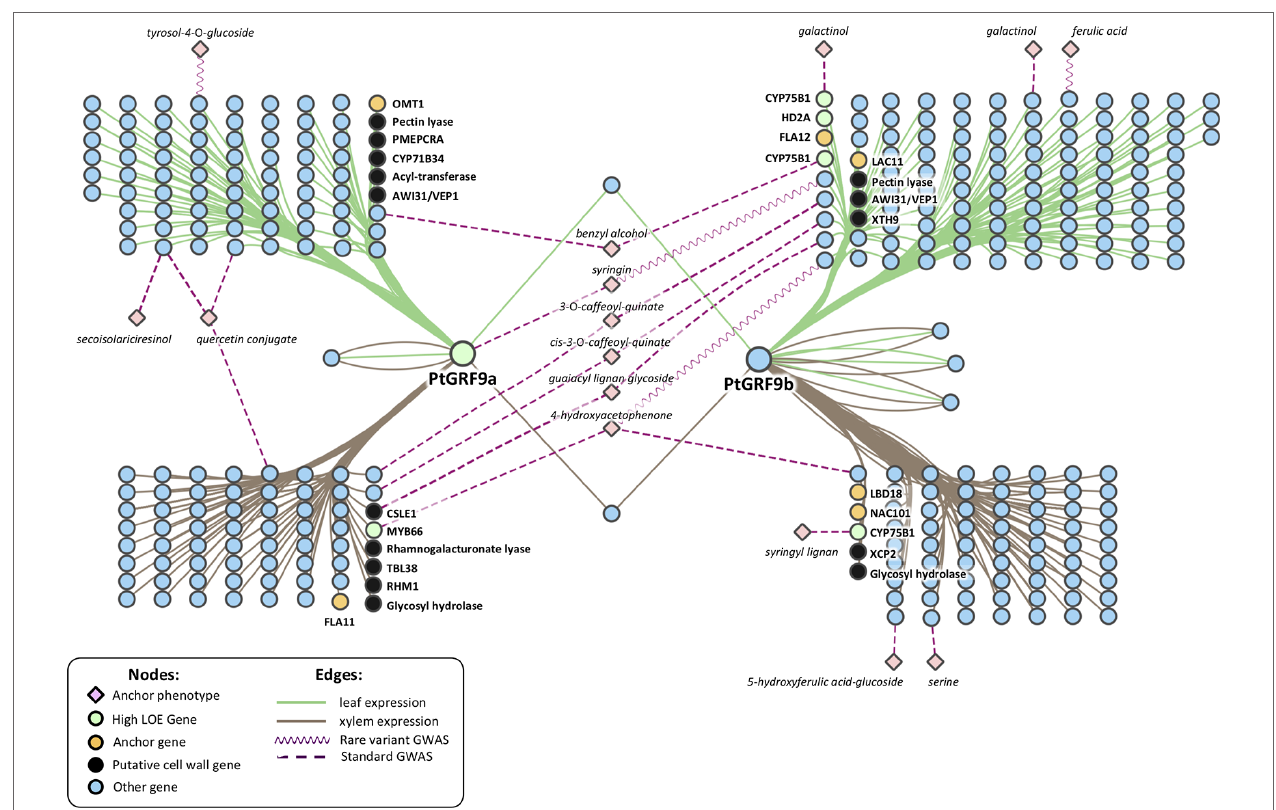
FIGURE 6 | Two-hop network created by merging a 1-hop eQTN network around the PtGRF9 paralogs and 1-hop metabolite-GWAS networks around anchor metabolites. See Supplementary Table S14 for node